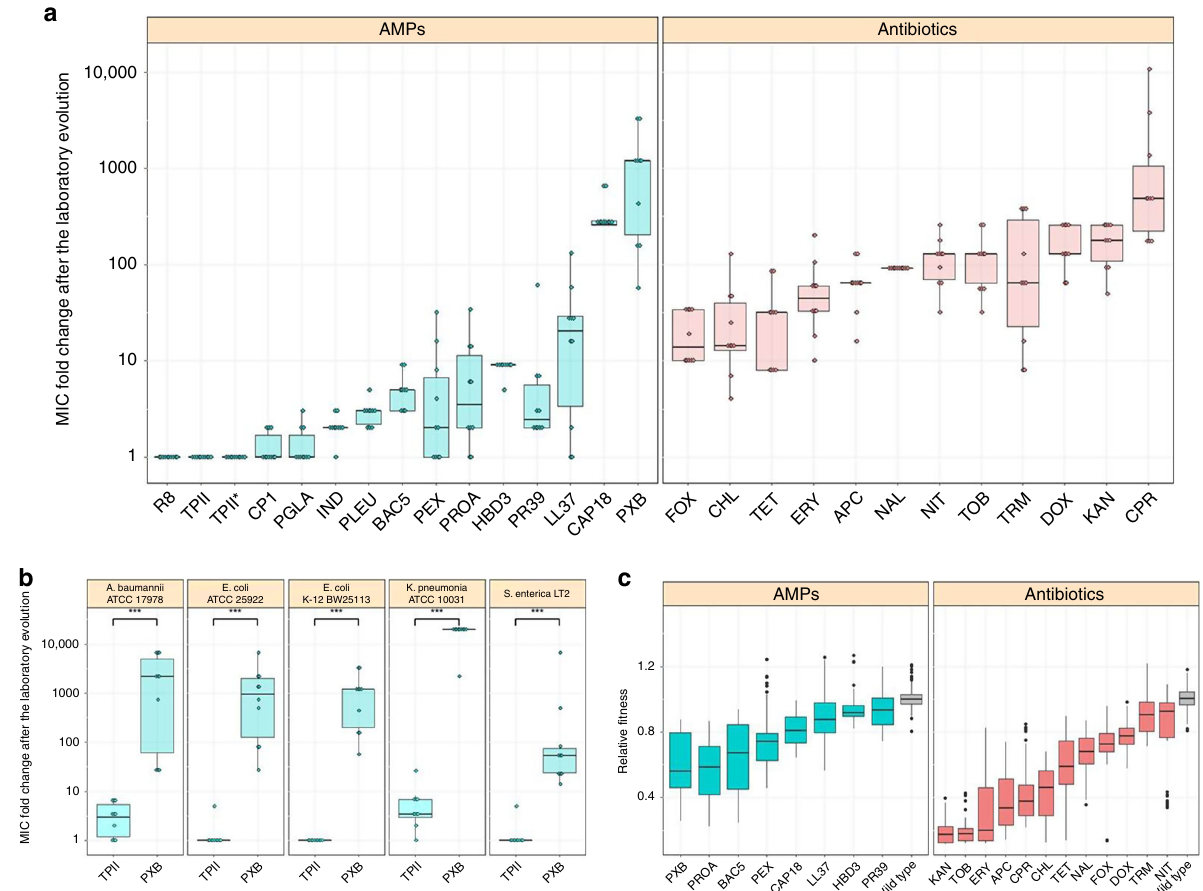
Fig. 1 MIC and relative fi tness of adapted lines after the laboratory evolution. a Relative resistance level in laboratory evolved E. coli K-12 BW2511 lines exposed to one of each 14 AMPs (blue) or 12 antibiotics (red), respectively (at least 9 parallel-evolved lines per drug). Altogether, lines exposed to AMPs ( N = 138) developed signi fi cantly lower resistance, than lines exposed to antibiotics ( N = 120) ( P < 0.0001, one-sided permutation test). The resistance levels reached were more heterogeneous across AMP treatments ( N = 14) than across antibiotic treatments ( N = 12) ( P = 0.03478 F -test). Each data point represents the MIC fold change of one of each parallel-evolved line. The mutD5 mutator strain exposed to TPII is marked by an asterisk (*). b Relative resistance level after laboratory evolution in clinical isolates under TPII or PXB stresses, respectively. Evolved lines exposed to TPII reached signi fi cantly lower resistance level than lines exposed to PXB (*** indicate the signi fi cant difference at least P -value = 1.65 × 10 – 4 , two-sided Mann – Whitney test, N = 10 each group). Each data point represents the MIC fold change of one of each parallel-evolved line. c Relative fi tness of 60 antibiotic-resistant and 38 AMP- resistant lines displaying at least twofold increments in resistance level to the drug indicated. Fitness was measured as the area under the growth curve in an antibacterial agent-free medium and was normalized to that of the wild-type (gray color). Throughout Fig. 1, boxplots show the median, fi rst and third quartiles, with whiskers showing the 5th and 95th percentile. For AMP and antibiotic abbreviations, see Supplementary Tables 1 – 2. Data in this fi gure are representative of at least two biological replicates. Source data are provided as a Source Data fi